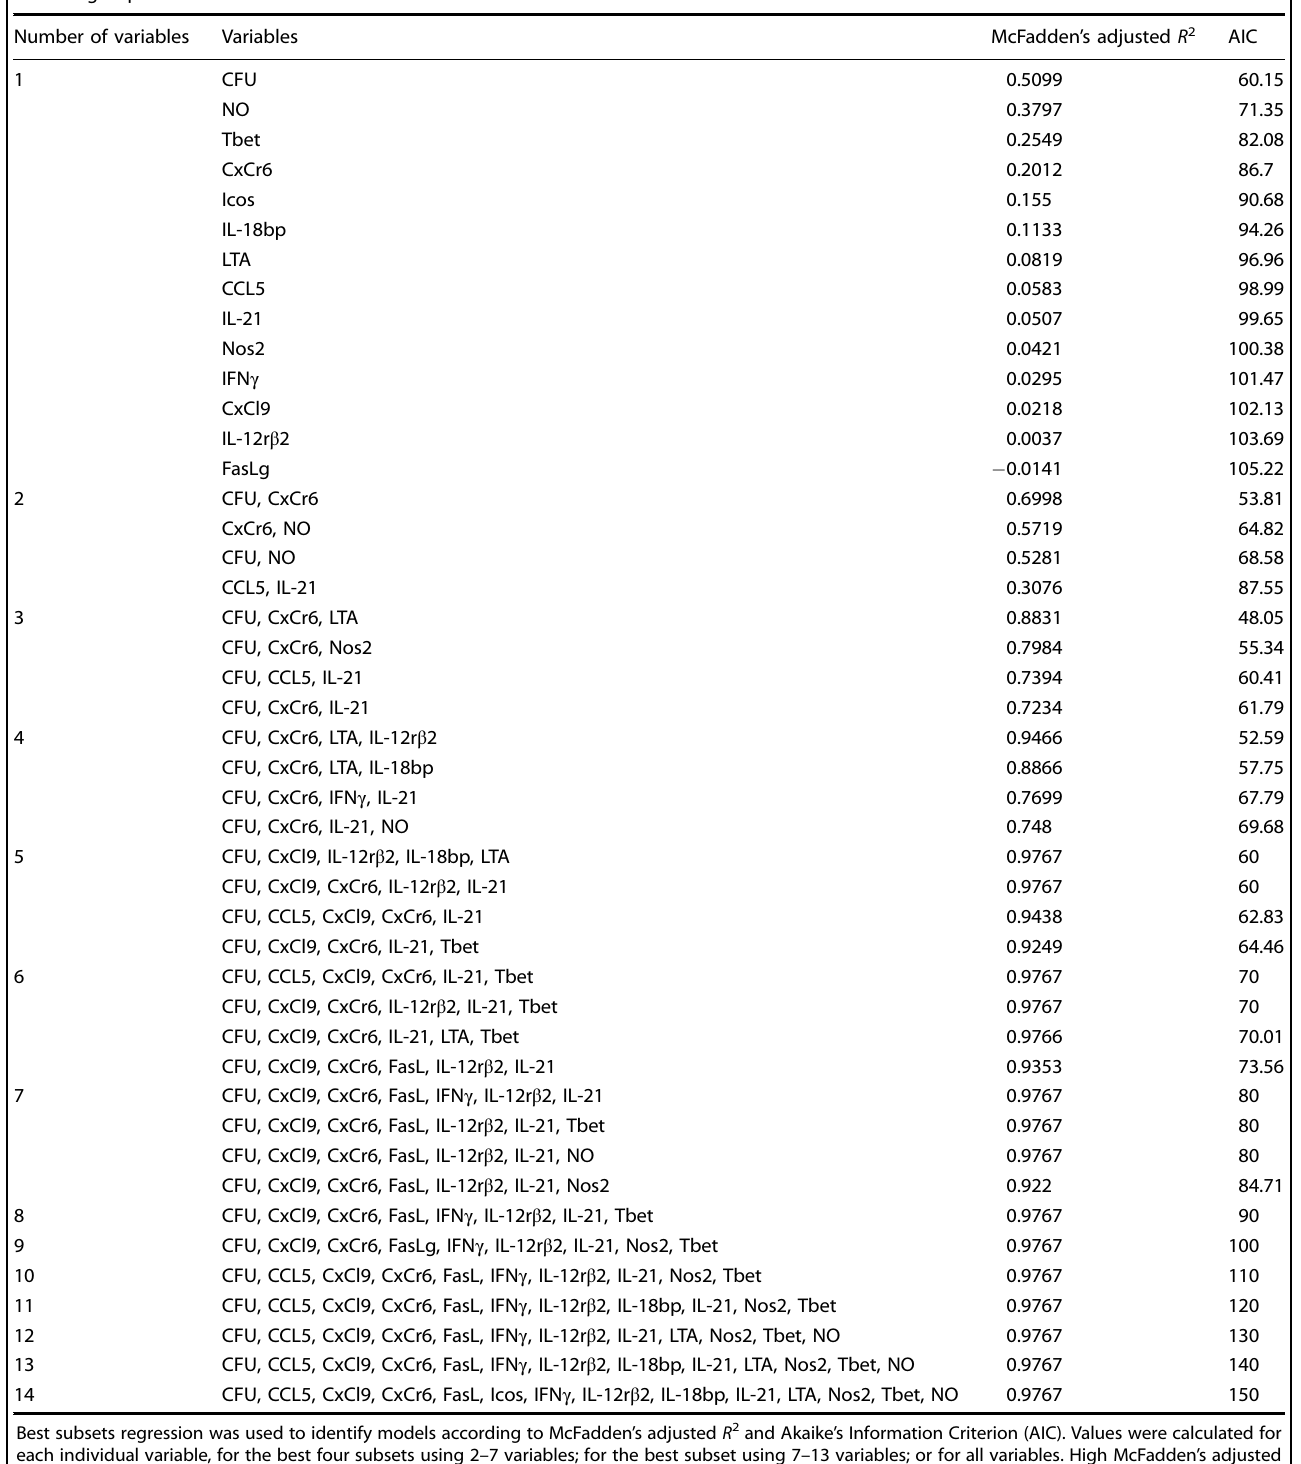
Table 3. Assessment of model fi t (McFadden ’ s Adjusted R 2 ) and parsimony (AIC) for the association between different subsets of variables and vaccine